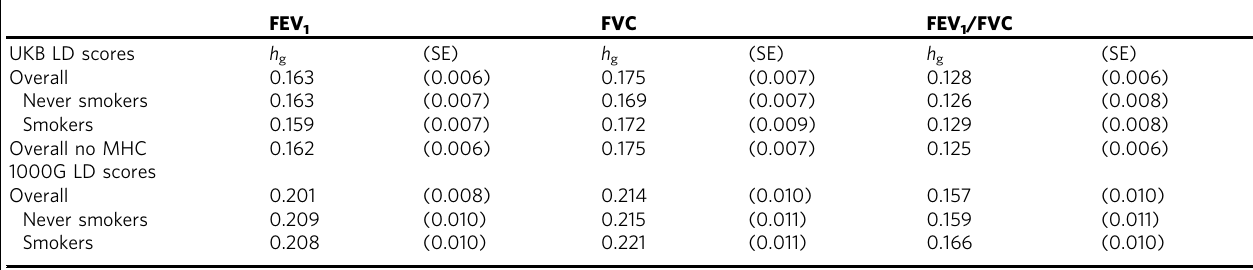
Table 1 Array-based heritability for FEV 1 , FVC, and FEV 1